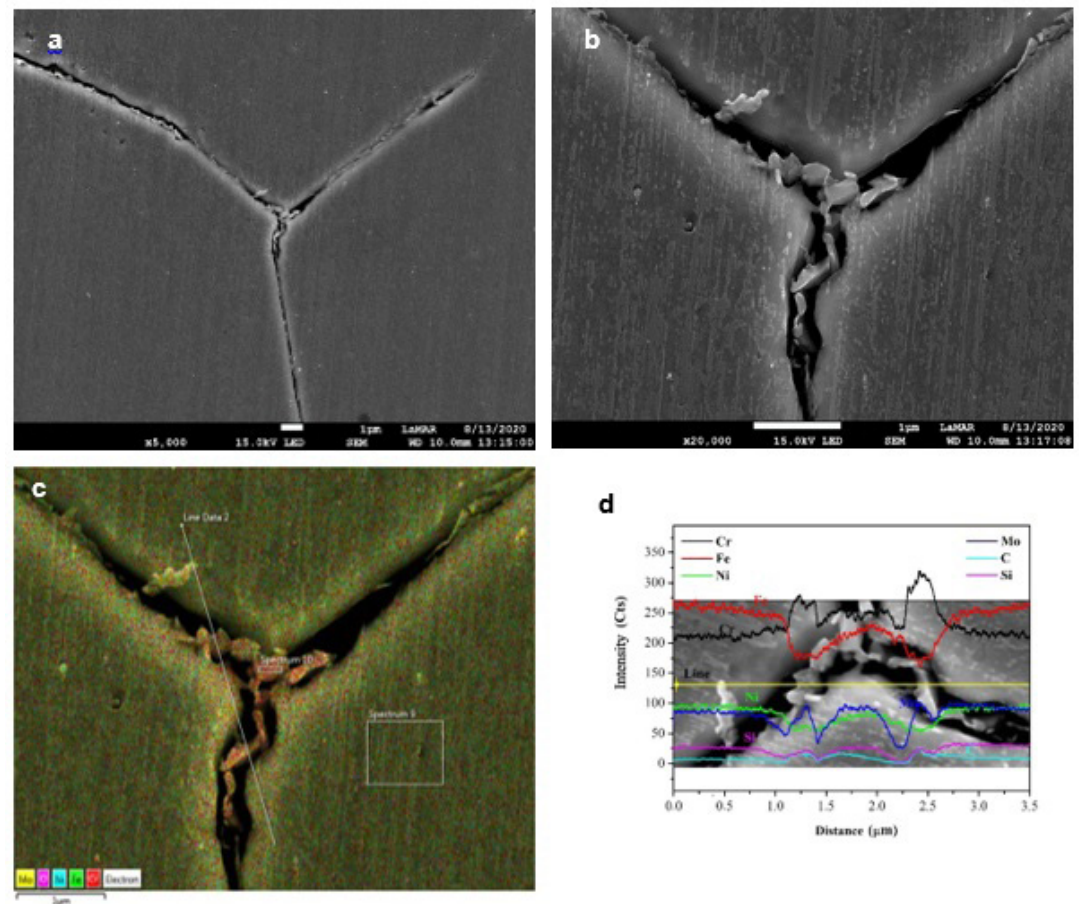
Figure 8. Discontinuous intergranular precipitates in thermal aging for 1500 h. Image obtained in SEM with (a) 5000X and (b) 20000X in secondary electron (SE) mode, (c) EDS map denoting the regions rich in Mo and (d) line scan denoting the regions rich in Fe, C, Cr, Ni, Mo and